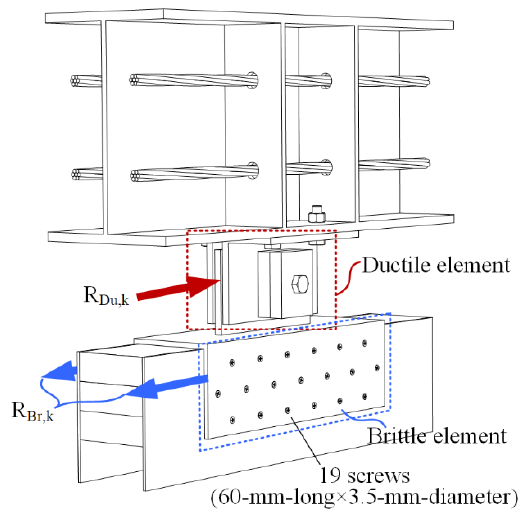
Figure 6. Schematics of one slip friction damper.